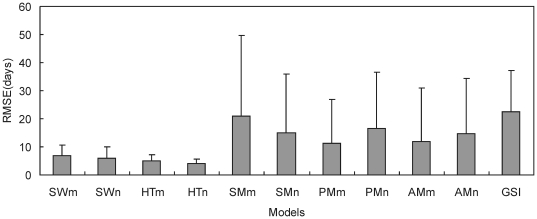
Average root mean square error (RMSE) of different phenology models for plant leafing using independent data.SWn, TPn, and AMn: Spring warming model (SW), Temperature-precipitation based leafing model (TP), and Alternating model (AM) with fixed starting date. SWm, TPm, and AMm: SW, TP and AM with parameterized starting date. SMn and PMn: Sequential model (SM) and Parallel model (PM) with section parameters estimated. SMm and PMm: SM and PM with all parameters estimated. GSI: Growth season index.